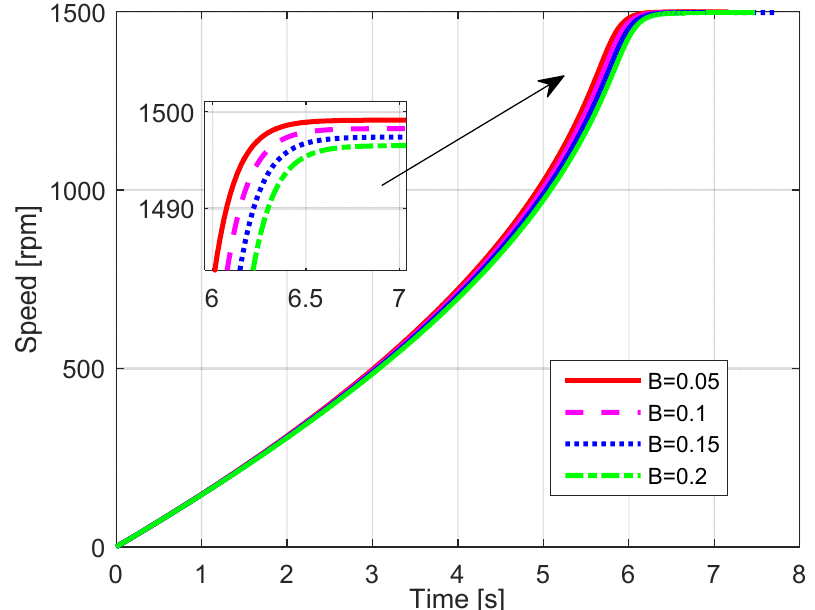
Figure 3. Impact of variation of the bearing loss on the speed-time curve during no-load direct startup ( J = 9.4 kgm 2 , U = 200 V).